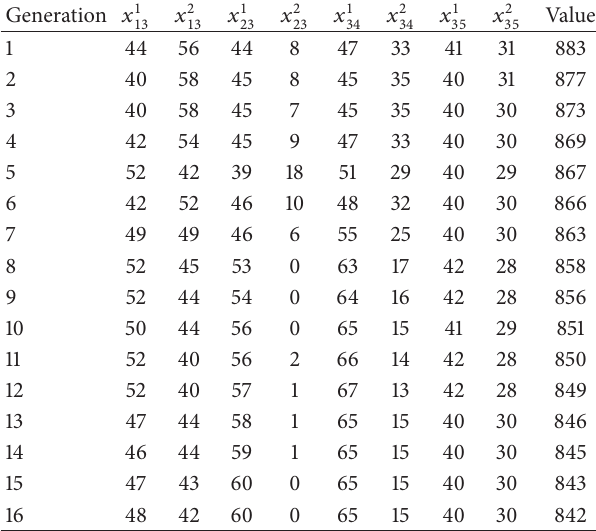
Table 6: The best solutions and objective values in different